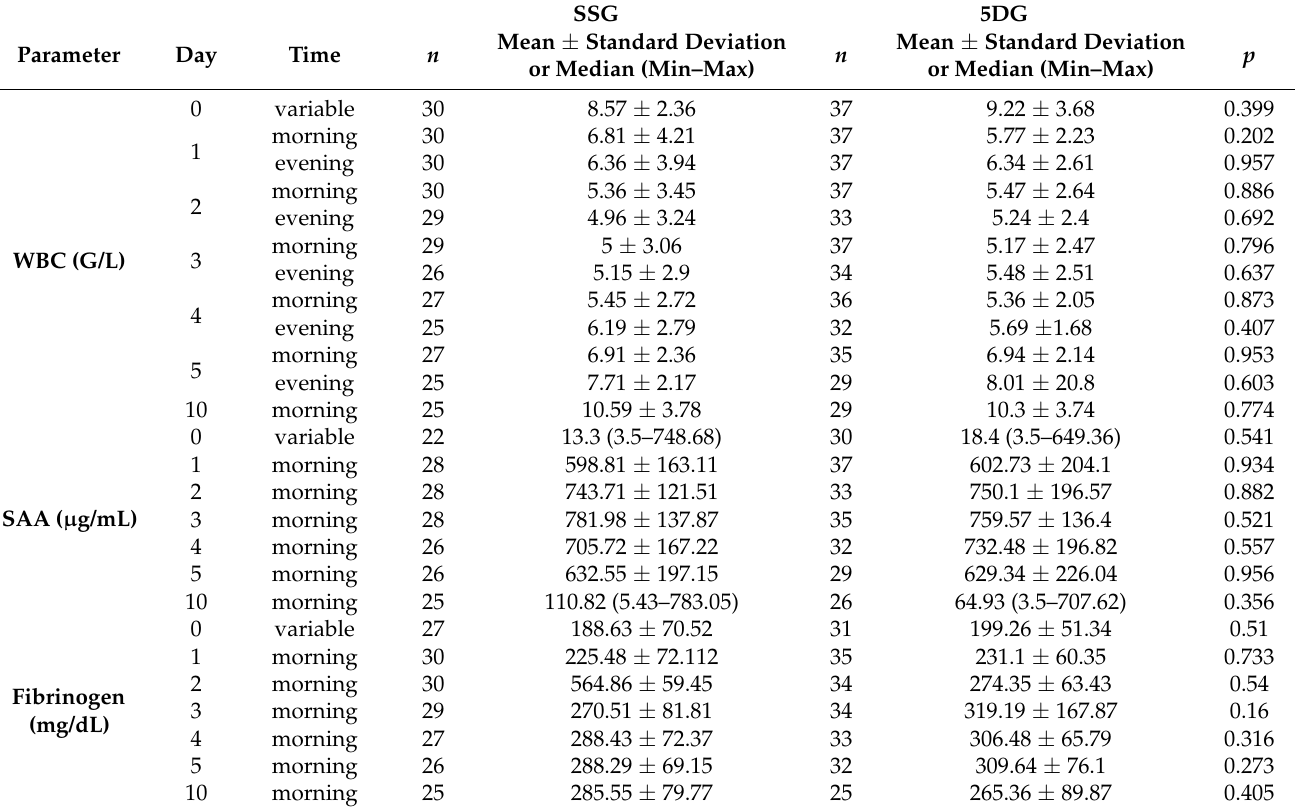
Table 3. Mean and standard deviation/median and of the laboratory parameters examined. SSG